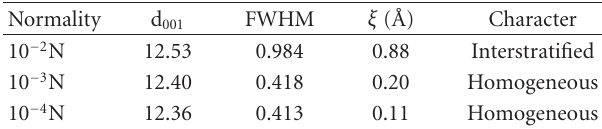
Table 1: d 001 and FWHM of the 001 reflection are given respectively in ˚A and in ◦ 2 θ -CuK α . The ξ parameter is calculated as the standard deviation of the lx (00l) values calculated for the Xi measurable reflections over the 2–35 ◦ 2 θ CuK α angular range.